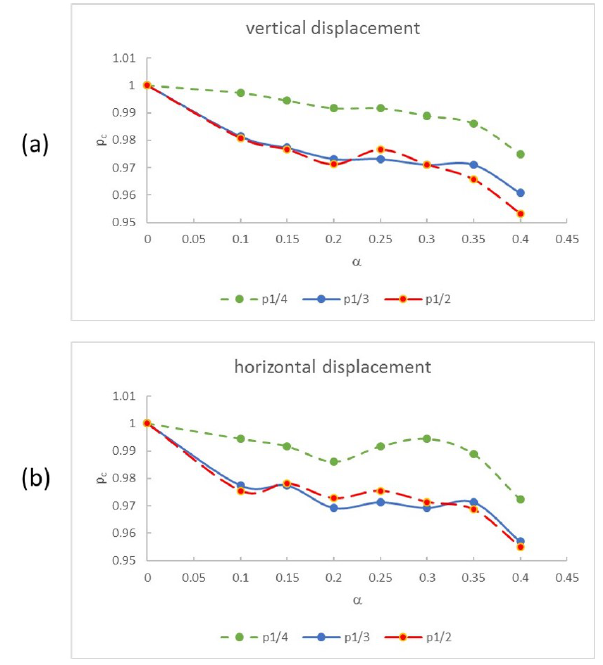
Figure 26. Critical speeds for p c and crack depth α : ( a ) when using vertical displacements and ( b ) when using horizontal